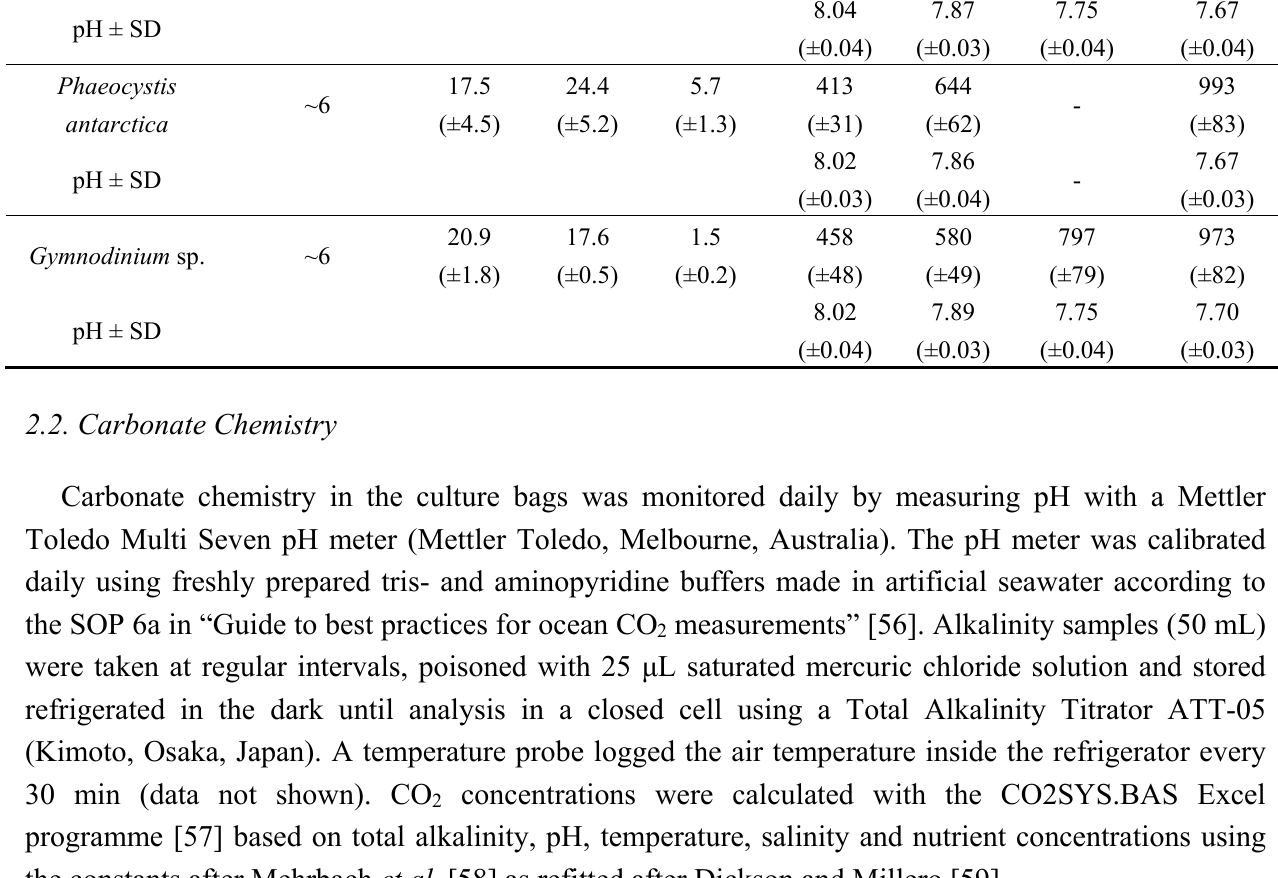
Table 1. Experimental conditions for all phytoplankton species. Values are averages with standard deviations, SD, in brackets. NO